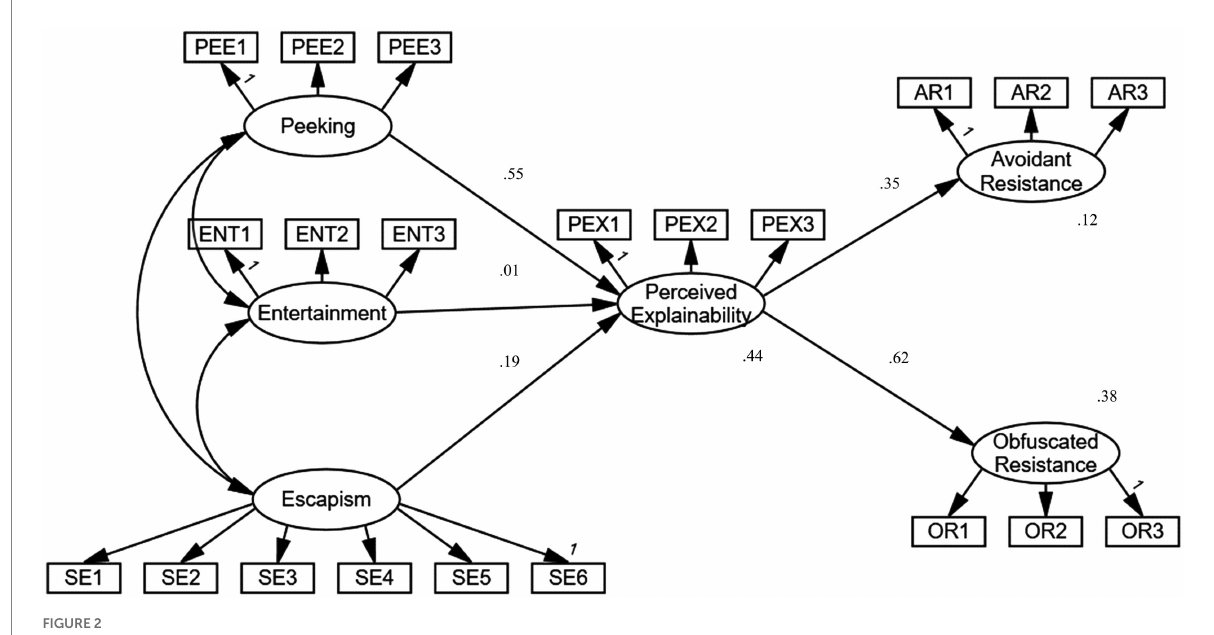
FIGURE 2 Structural equation model with results of the AMOS analysis ( N = 2,000).